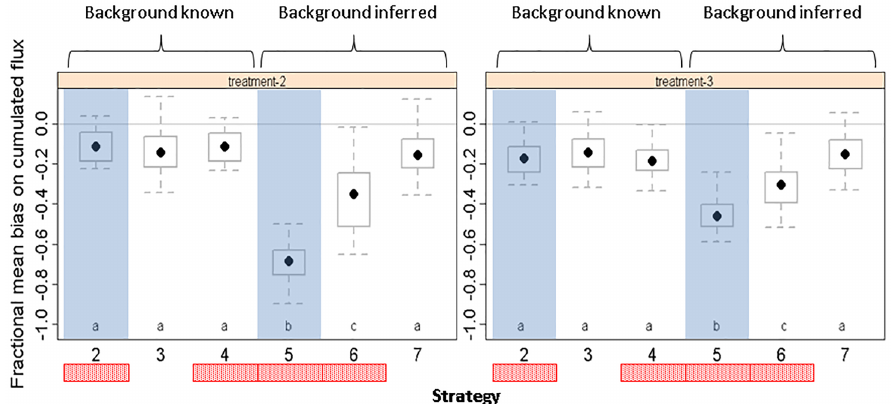
Figure 14. Comparison of biases for all source inference strategies. In strategies C2, C3 and C4 we hypothesise that we have perfect knowledge of the background concentrations, while in strategies C5, C6 and C7 background concentrations are inferred together with the sources. In strategies C2, C4, C5 and C6 (red rectangles) we suppose that plots from the same treatment have the same emissions, while in strategies C3 and C7 we infer each plot separately. In strategies C2 and C5 we assume single sensors are placed above each plot (blue shades), while in strategies C3, C4, C6 and C7 we assume two sensors are placed above each